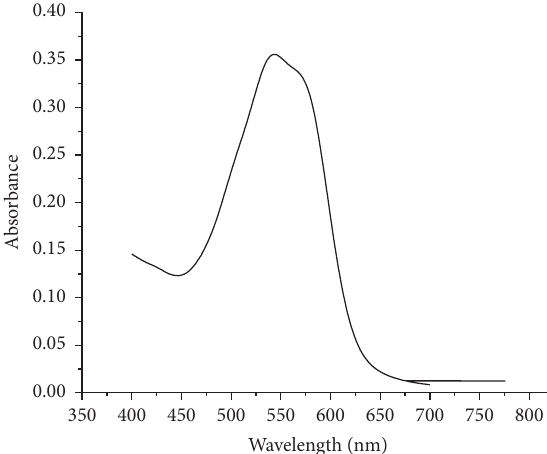
Figure 1: UV-Vis spectrum of the Al-EBT-F complex in water at 5 × 10 − 5 M concentration.